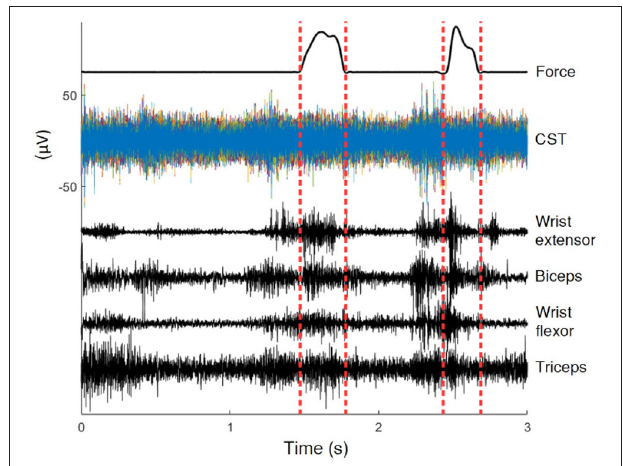
FIGURE 1 | Recordings of a typical trial. In this 3 s trial the animal was in contact with the rod for less than 0.5 s, the interval marked by dashed lines. The position is only known within the